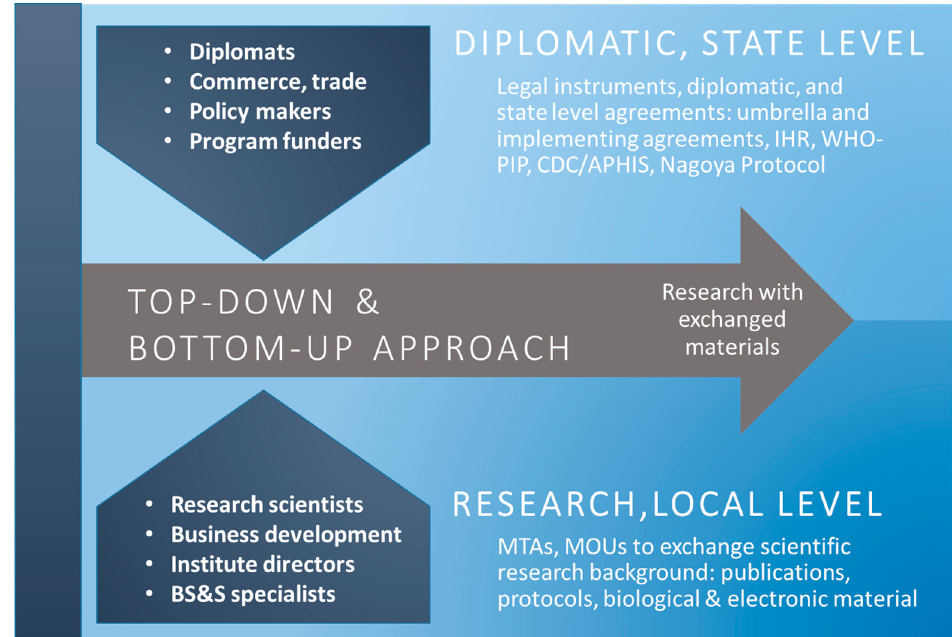
Figure 2. Dual top-down and bottom-up approach to yield research with exchanged materials and data. Parallel approach with diplomatic, state, and research level stakeholders is needed to better enhance research and scientific transparency.